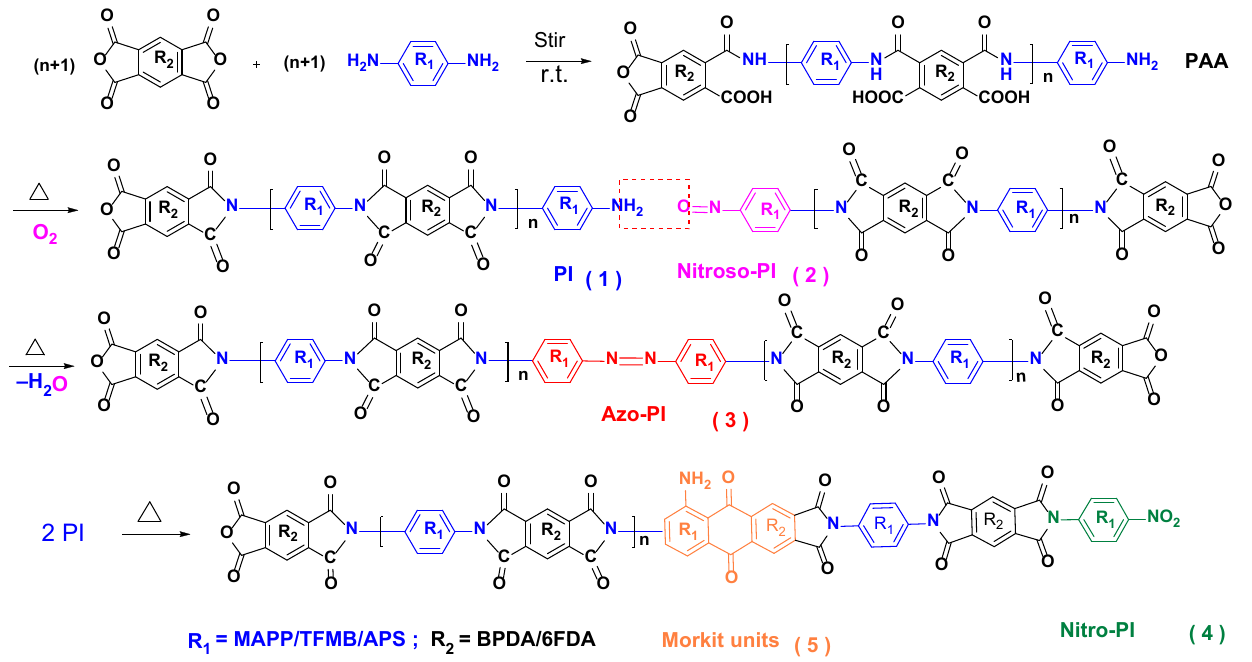
Scheme 1. The possible colored reactions during thermal imidization of PAA to PI ( 1 ) with chromophores of –N=O ( 2 ), –N=N– ( 3 ), –NO 2 ( 4 ), and colored Morkit units ( 5 ) production.